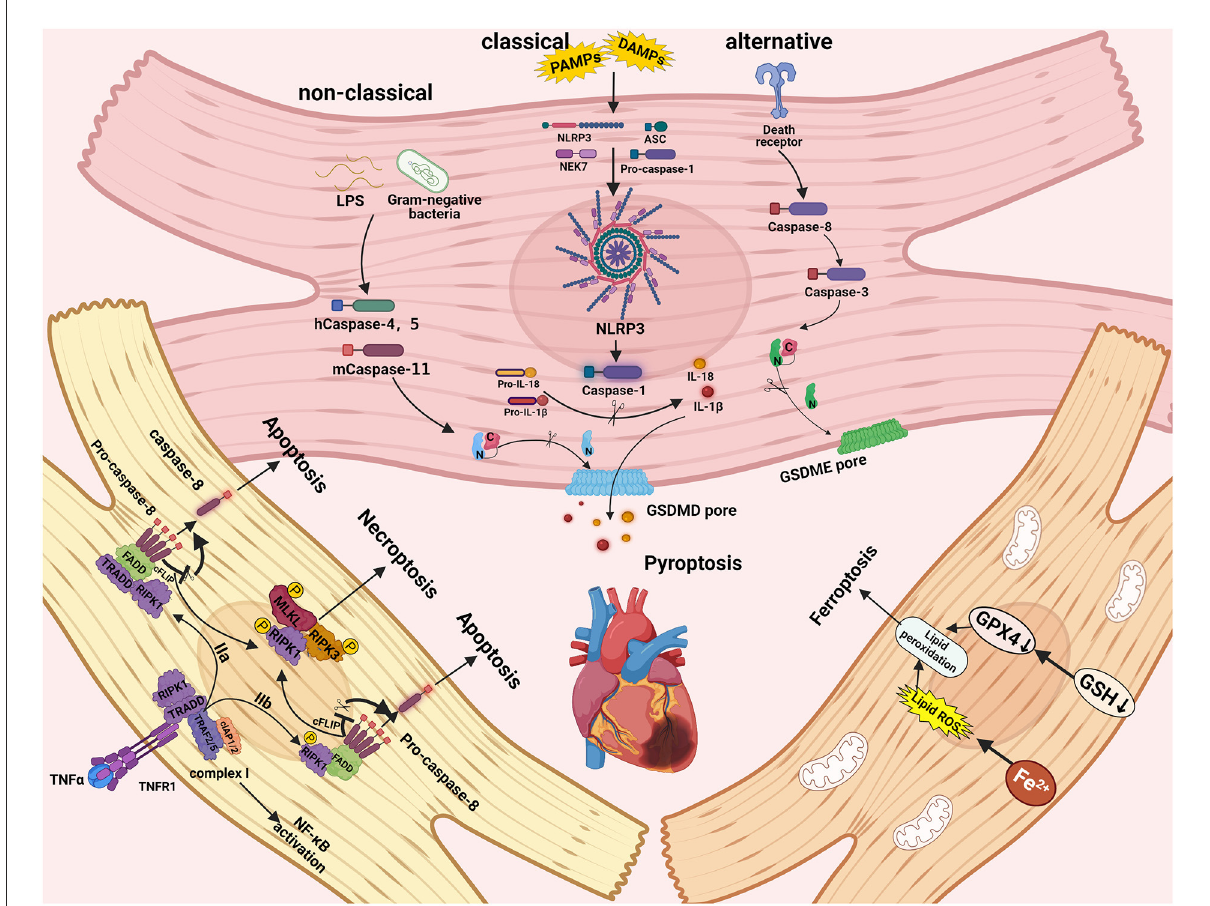
FIGURE1 The molecular signaling mechanisms and pathways of pyroptosis, necroptosis, and ferroptosis in cardiac cells. Necroptosis can be triggered by RIPK3 and RIPK1, which recruit MLKL to form the necrosome. The caspase-1 induced classical inflammasome pathway, caspase-4, caspase-5, and caspase-11 induced non-classical pathways, and caspase-3 and caspase-8 induced alternative pathways can trigger pyroptosis. Ferroptosis can be activated by iron accumulation and low levels of GSH-induced lipid